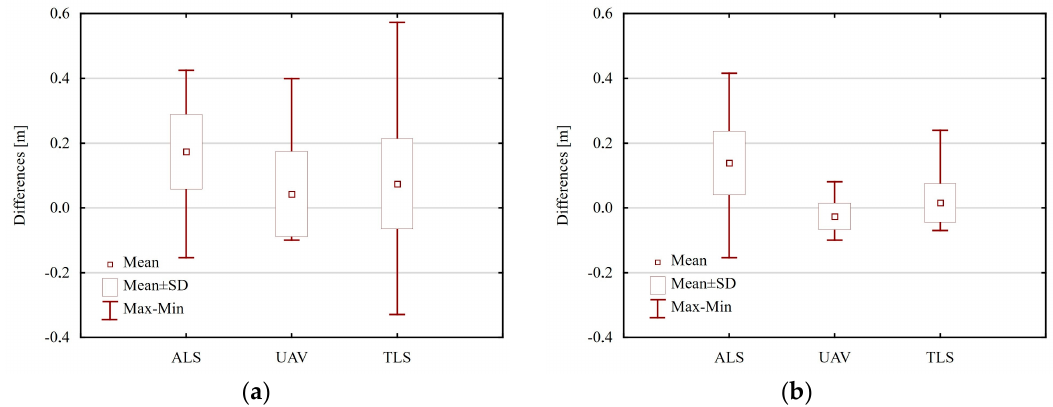
Figure 13. Box plot presenting parameters of accuracy evaluation for data obtained from ALS, UAV, and TLS against the RTK/RTN GNSS measurements: ( a ) for points located on trails and in their immediate vicinity; and ( b ) for points located on the trails (source: authors’ own study).